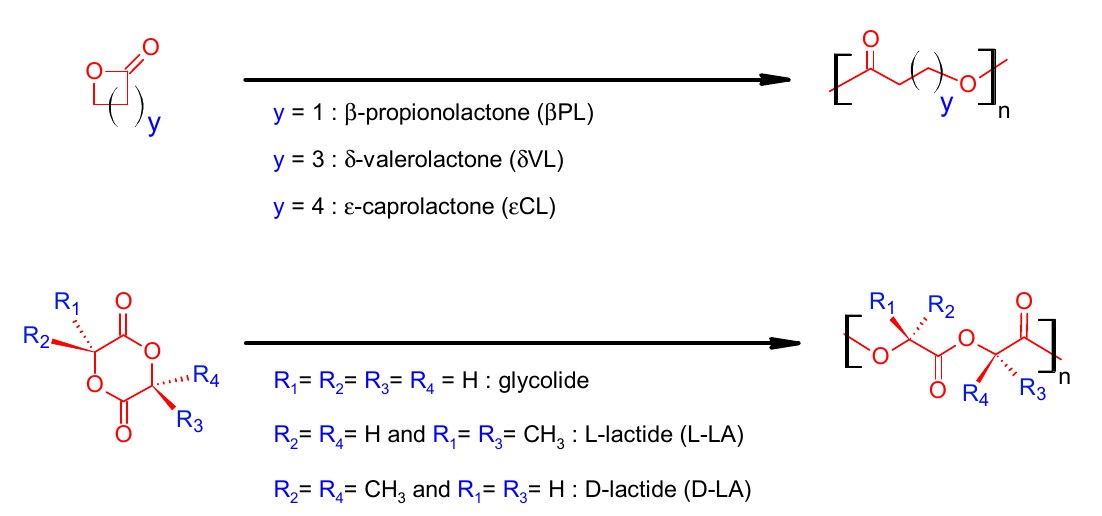
Figure 4. Monomers of choice for ring opening polymerization (ROP) polymerization [10].